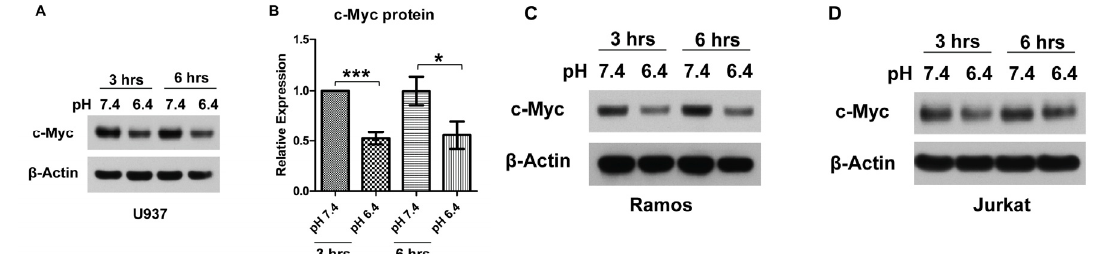
Figure 1. c-Myc protein is downregulated by acidosis in lymphoma and leukemia cell lines. ( A ) U937 lymphoma cells treated with pH 7.4 or pH 6.4 for three and 6 h